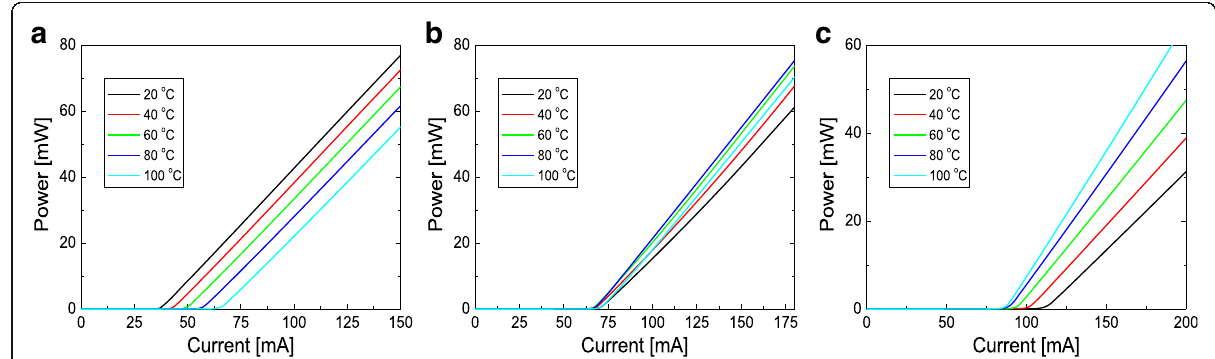
Fig. 3 L - I curves for temperatures from 20 to 100 °C when the doping concentrations of the barrier are a 1 × 10 17 cm − 3 , b 2 × 10 18 cm − 3 , and c 3 × 10 18 cm − 3 . Here, the barrier thickness is fixed at 10